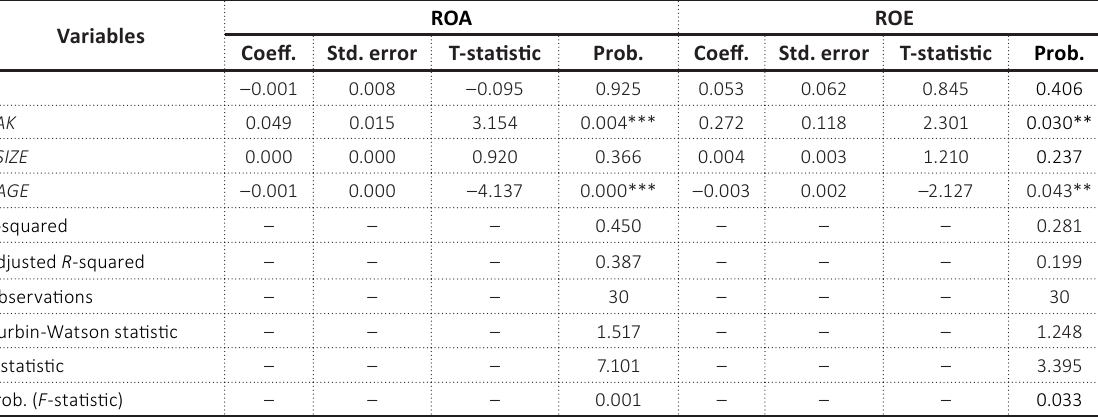
Table 4. Regression